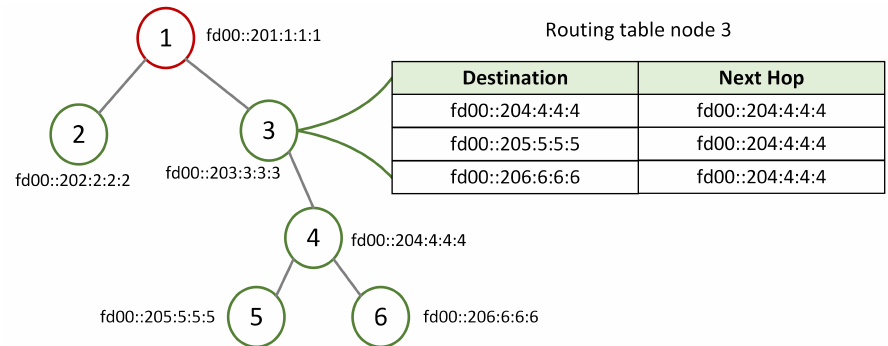
Figure 1. Example of routing table created by the IPv6 routing protocol for low-power and lossy networks (RPL) in storing mode for node